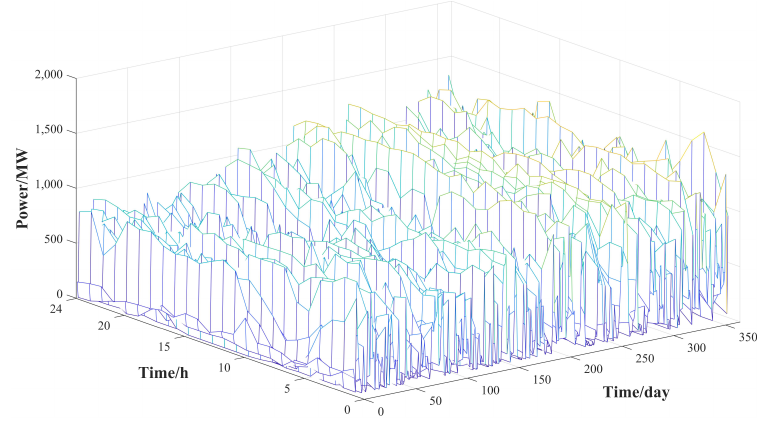
Figure 5. The annual wind power output curve in a certain region.